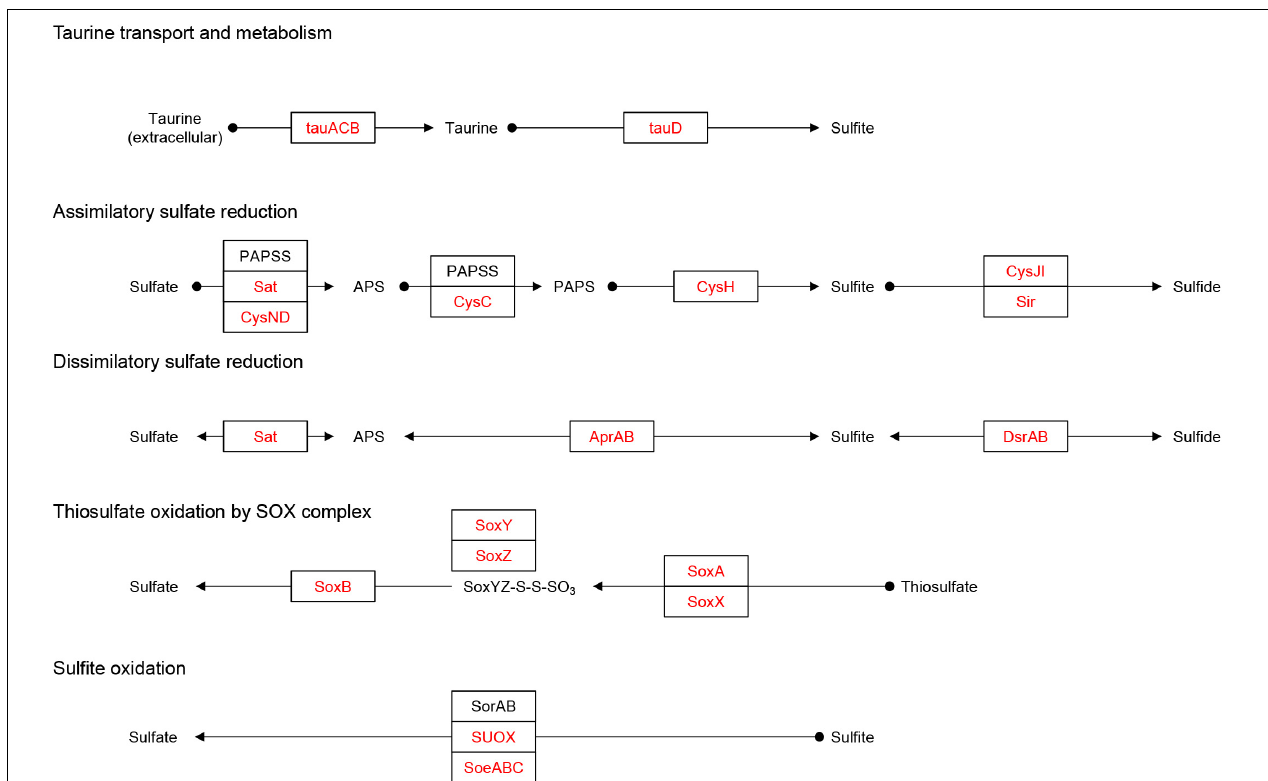
FIGURE 5 | Identification of the sulfur metabolism pathway. Adapted from KEGG (https://www.kegg.jp/pathway/map00920). Solid black circles indicate chemical compounds. Squares indicate gene names. The red fonts in the square indicates the names of genes identified in the MAGs, and the black fonts indicates genes that were not identified. The arrow indicates the direction of the reaction